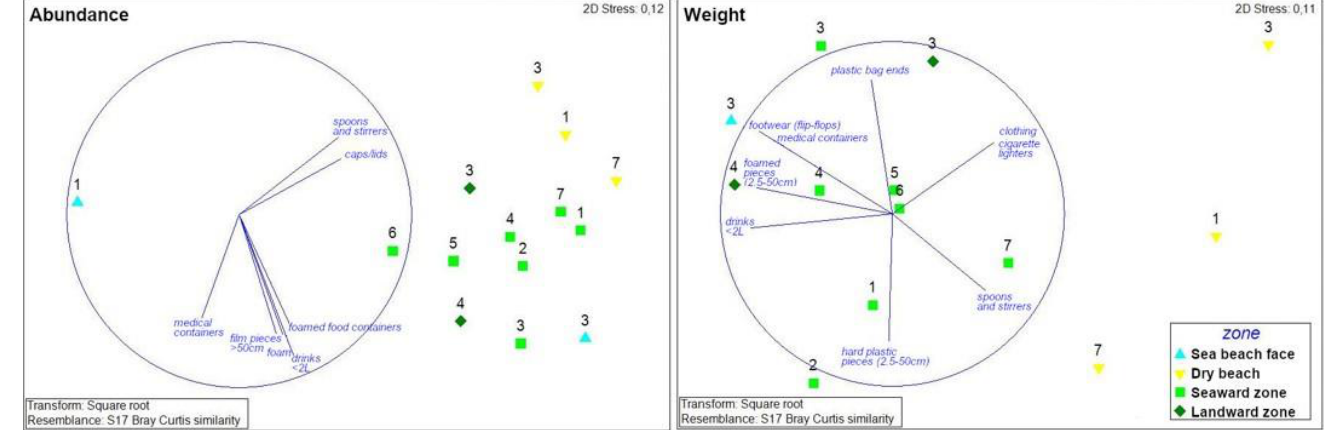
Figure 5. Caribbean Sea coast. Nonparametric multi-dimensional scaling ordination for litter abundance and weight based on litter categories recorded at each coastal zone. Colors (cyan, yellow, light and dark green) correspond to the four zones investigated (beach face, dry beach, seaward and landward mangrove zones, respectively), while labels from 1 to 7 correspond to the sites investigated. Vector labels refer to litter categories that showed a Pearson correlation > 0.7 and 0.8 (for litter abundance expressed in number of items and weight, respectively).